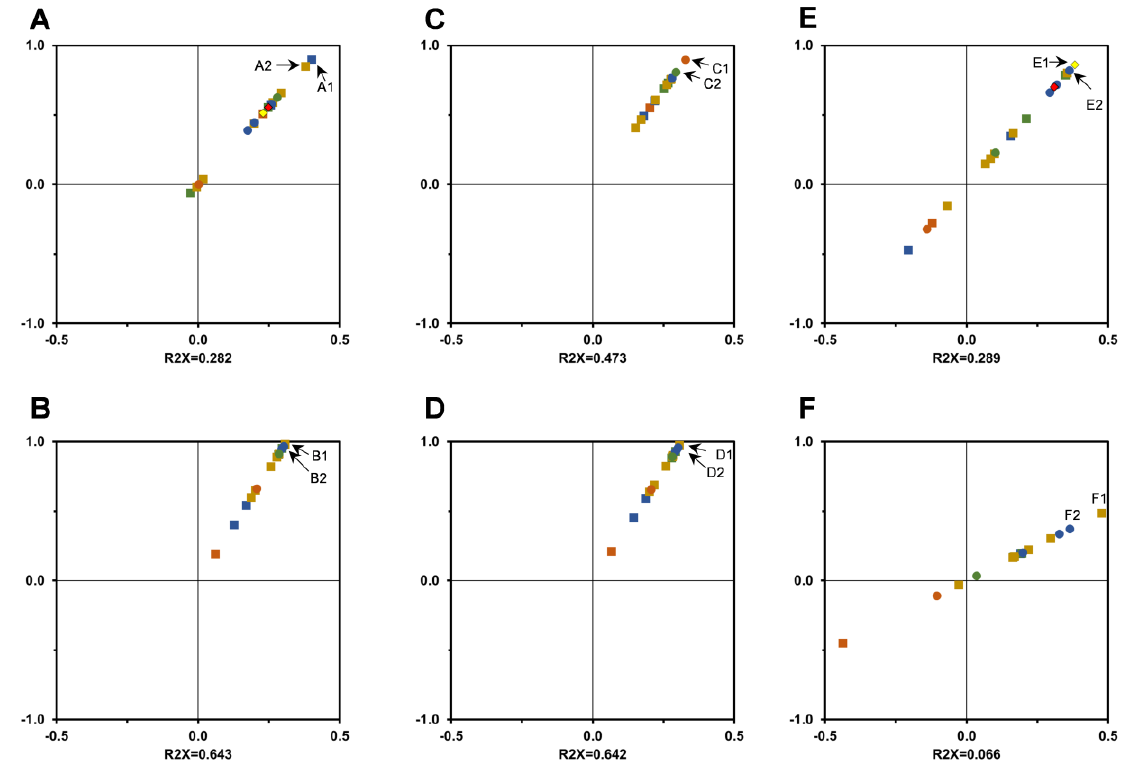
Figure 7. Correlation between individual phytochemicals and ABTS •+ scavenging (( A ): HE